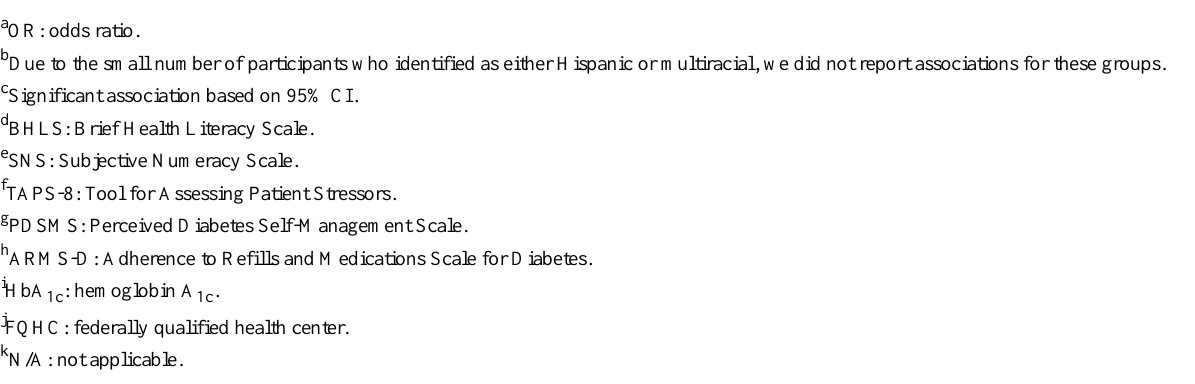
Low-dose choice, OR